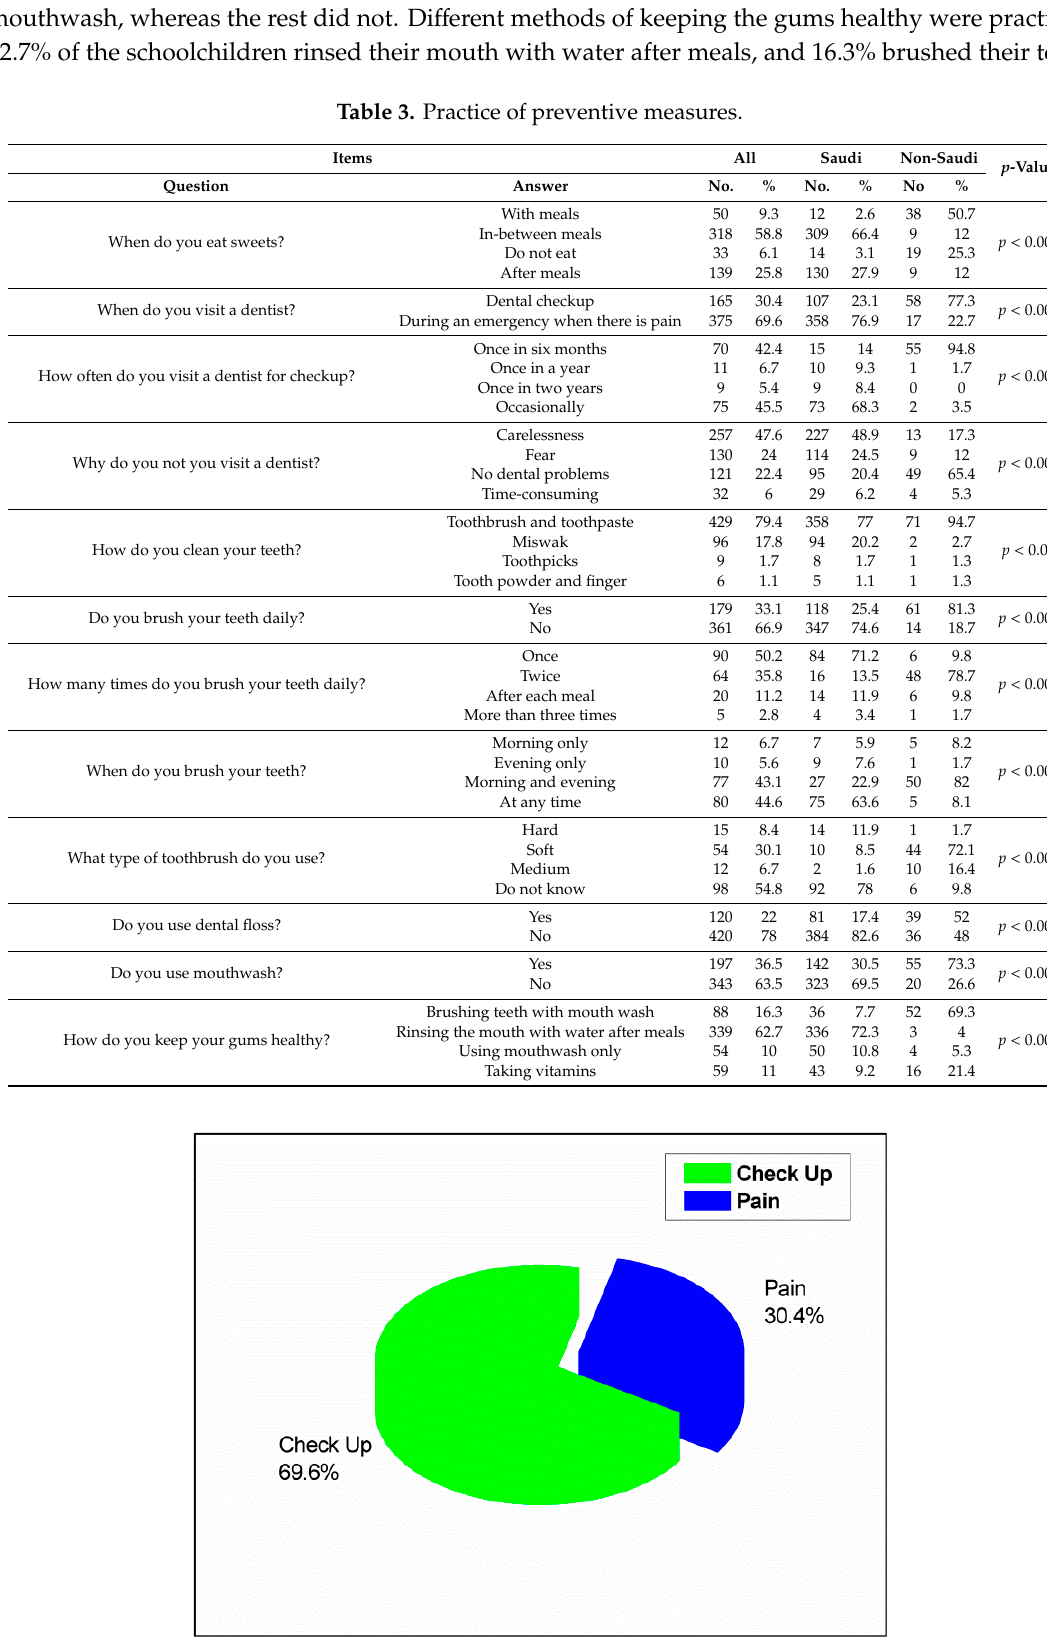
Figure 4. Toothbrushing.